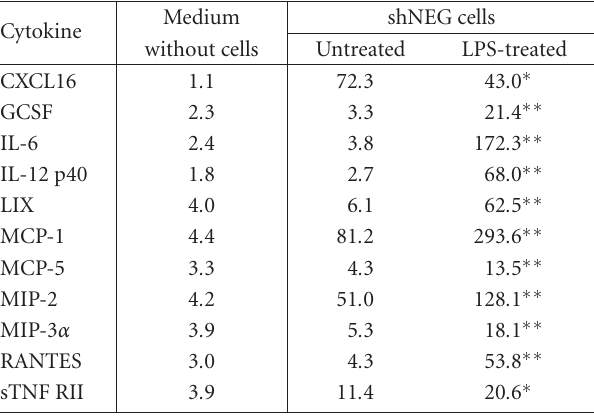
Table 3: Cytokines secreted by untreated and LPS- (100ng/mL) treated shNEG cells during 48h incubation. Arbitrary units com- pared to positive controls (100) are presented. Mean